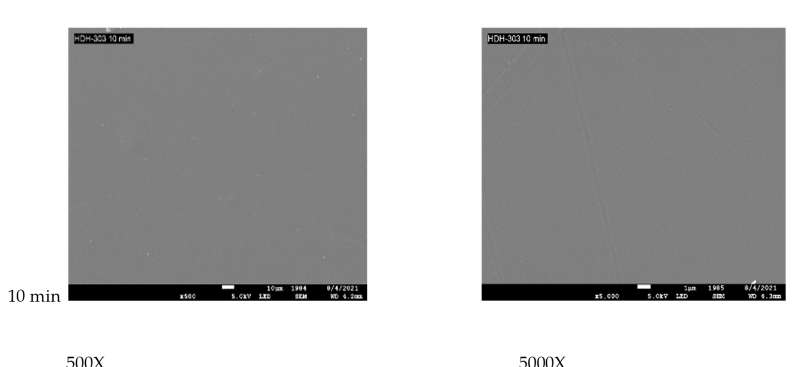
Figure 7. SEM surface topographic images at 500 × and 5000 × magnification after 0, 5, and 10 min treatment with VUV photo-oxidation.